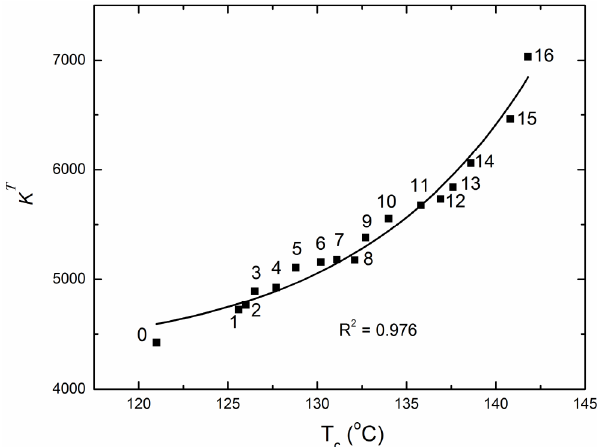
Figure 1. Dielectric property of crystals along growth direction.